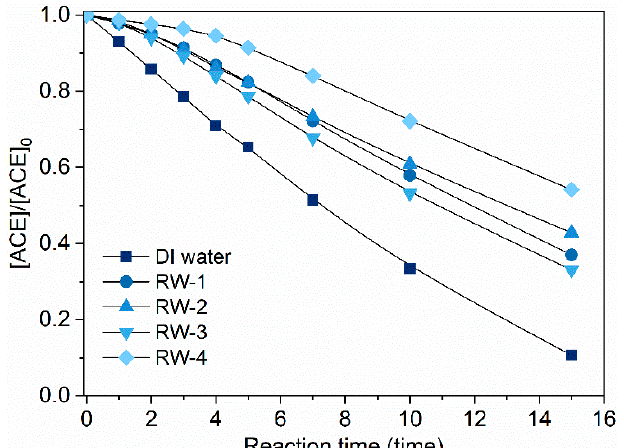
Figure 7. Degradation of ACE by O 3 / PMS under background of four real waters. Conditions: [ACE] 0 = 8.0 mg · L − 1 ; pH = 7.4; 15 ± 1 ◦ C; [PMS] 0 = 0.4 mM; O 3 dosage 1.25 ± 0.1 µ M · min − 1 (60 ± 5 µg·min − 1 )). Table 1. Water quality of the four real waters (RWs)